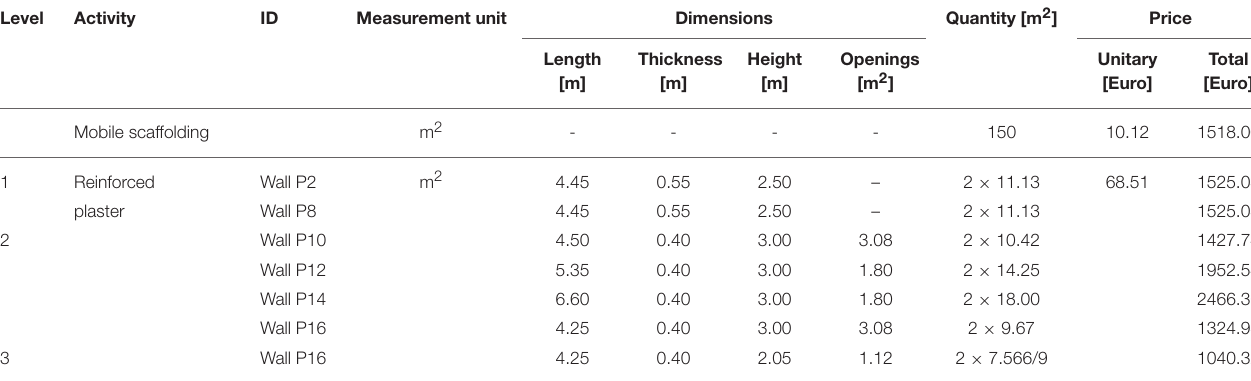
TABLE 4 | Seismic upgrading interventions